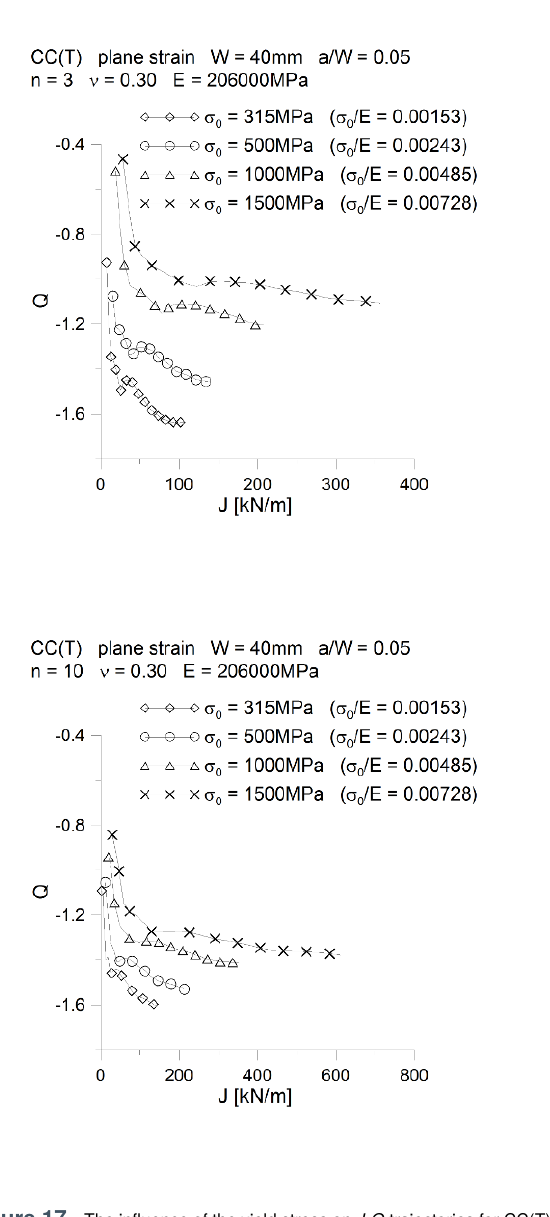
Figure 17. The influence of the yield stress on J-Q trajectories for CC(T) specimens with crack length a / W =0.05 for different power exponents in R-O relationship: a) n =3; b) n =5; c) n =10; d) n